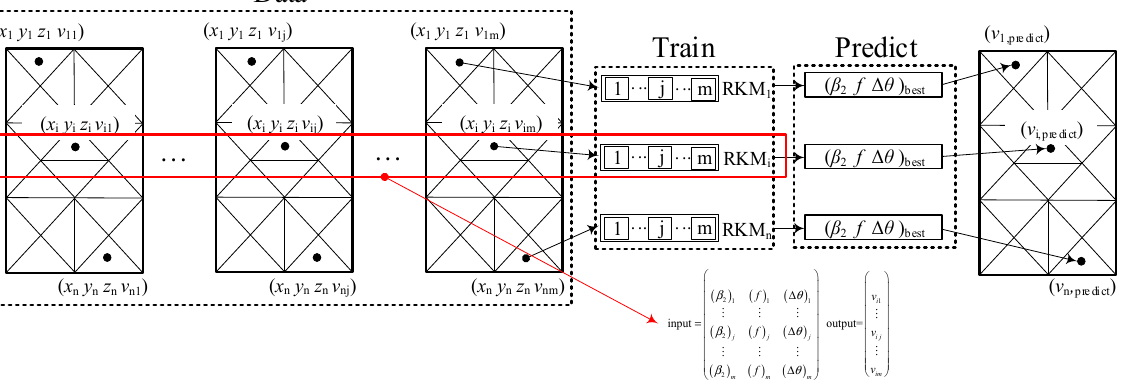
Figure 22. Flow field prediction process.